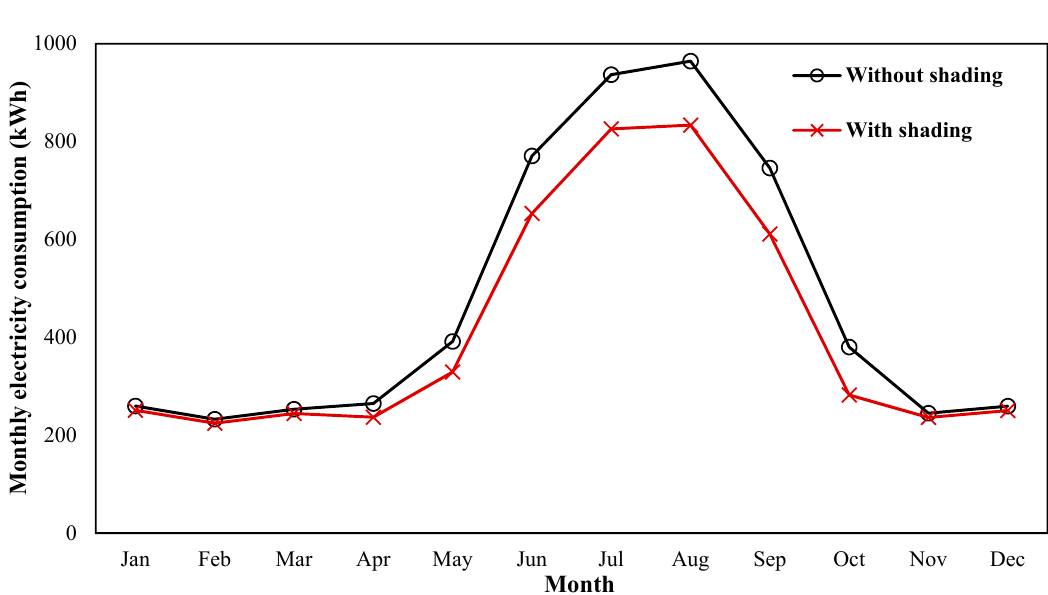
Figure 14. Monthly electricity consumption with and without shadings. Table 11. The annual energy consumption and energy saving for the building with and without shading.